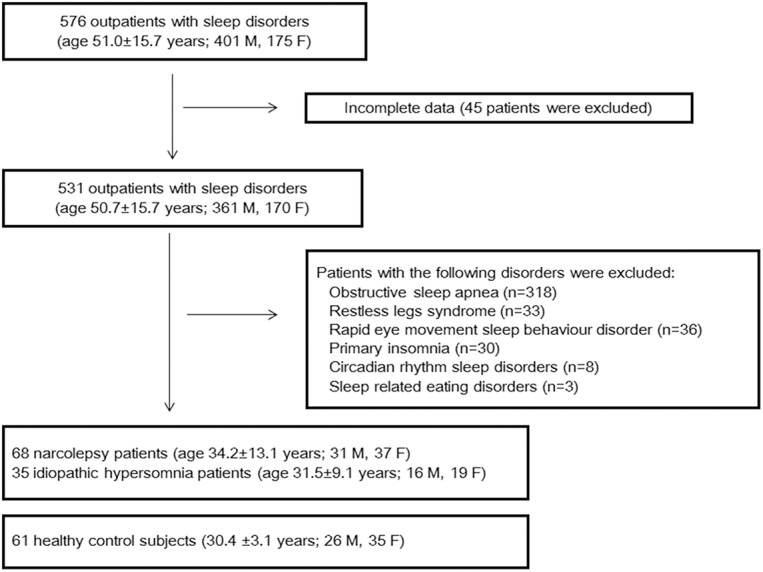
Flow chart of the patient selection method.